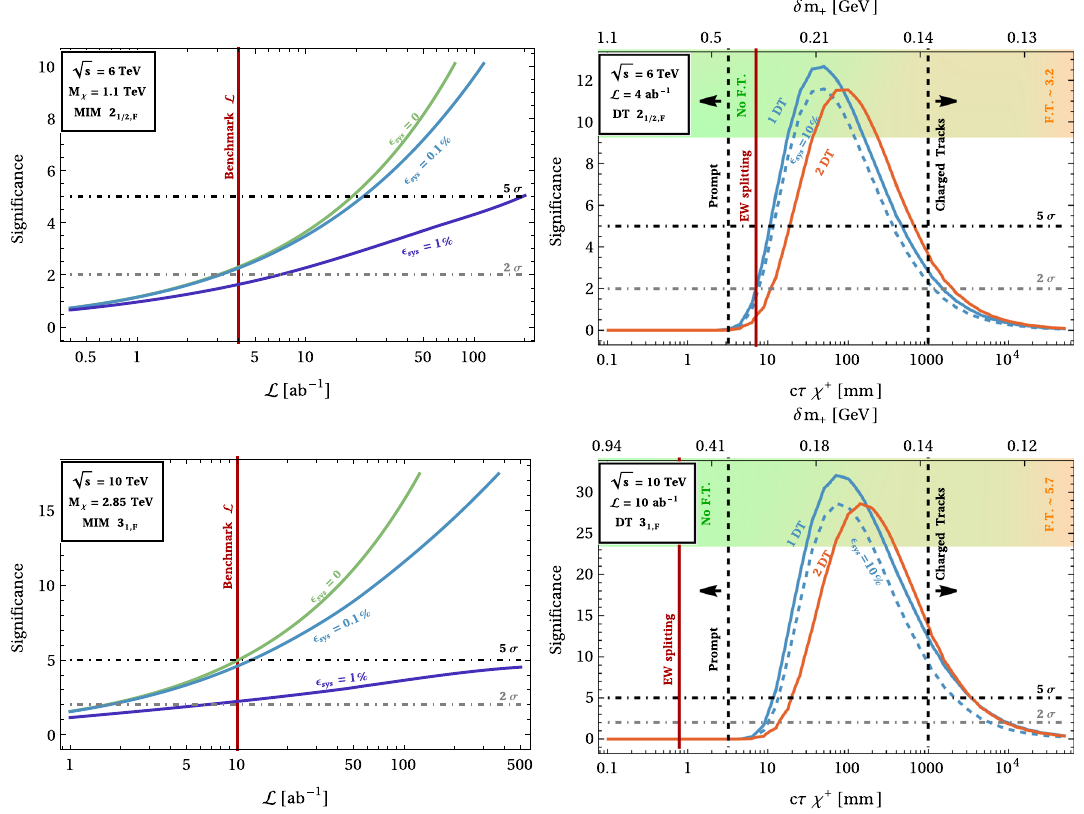
correspond to the reach with 1 and 2 disappearing tracks. For the single track search the solid (dashed) line assumes 0 (10%) systematics on the background. Fine-Tuning values computed on δ m + following Eq. (12) are displayed as color code from green (no fine-tuning) to red (higher fine-tuning). Bottom two rows: same as for the top rows, but for the case √ √ s = 6 TeV (left) and s = 10 of the 3 1 of mass M χ = 2 . 85 TeV and TeV